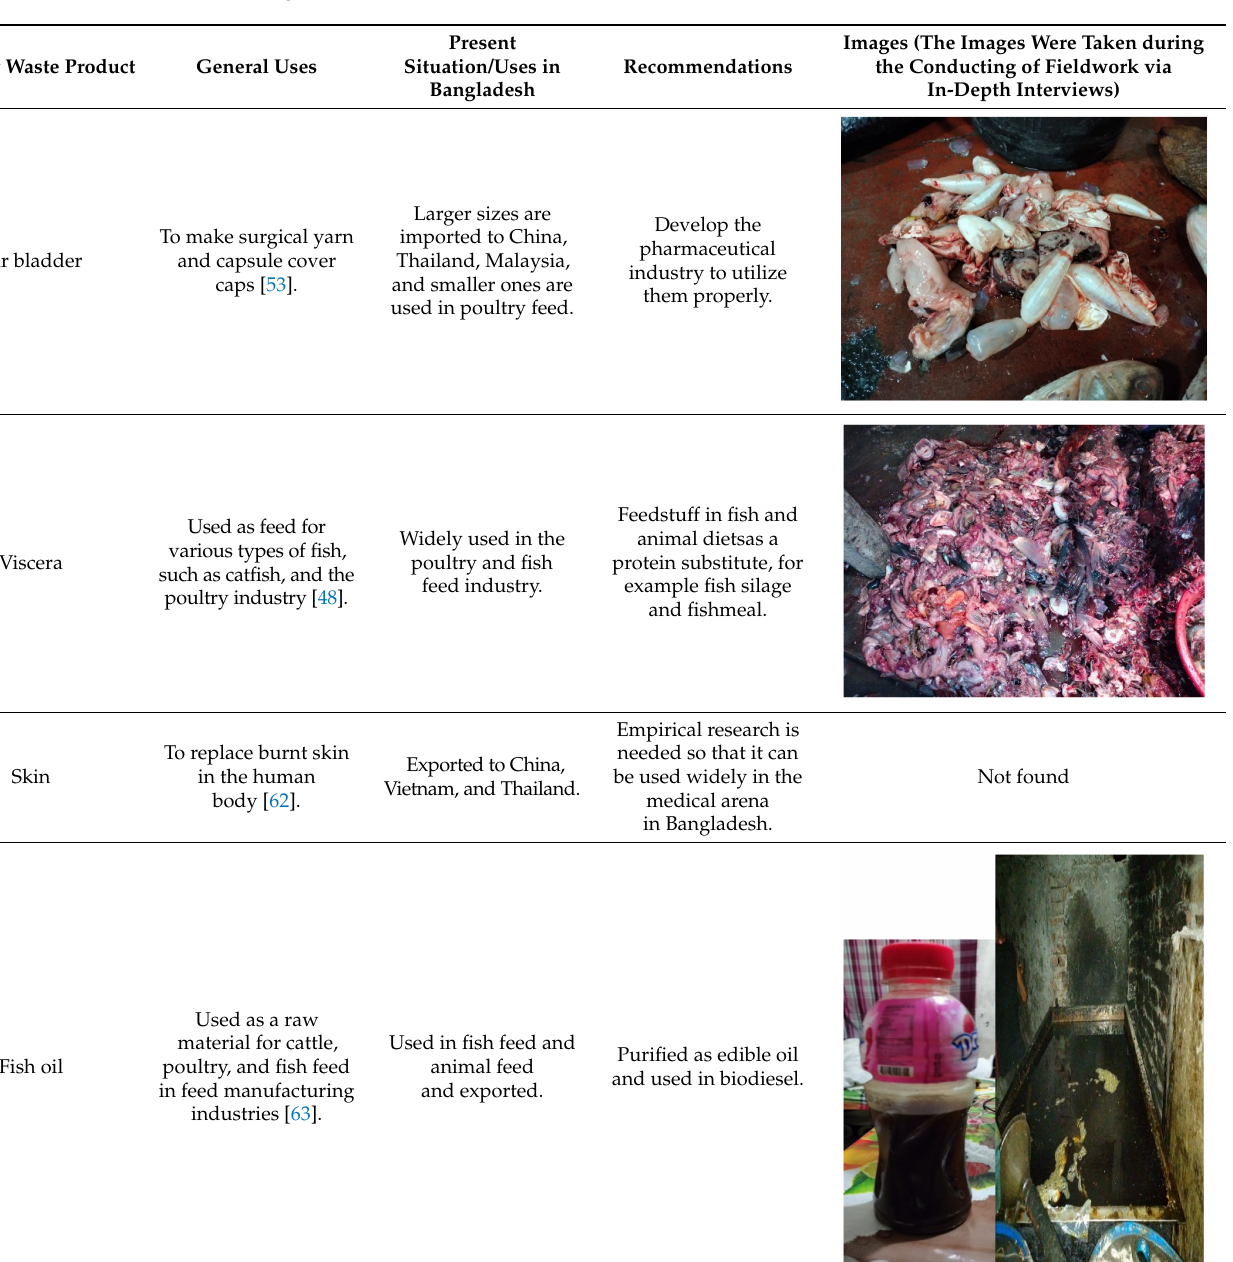
Table 3. Summary of fishery waste and fishery by-products’ general uses and their present uses in